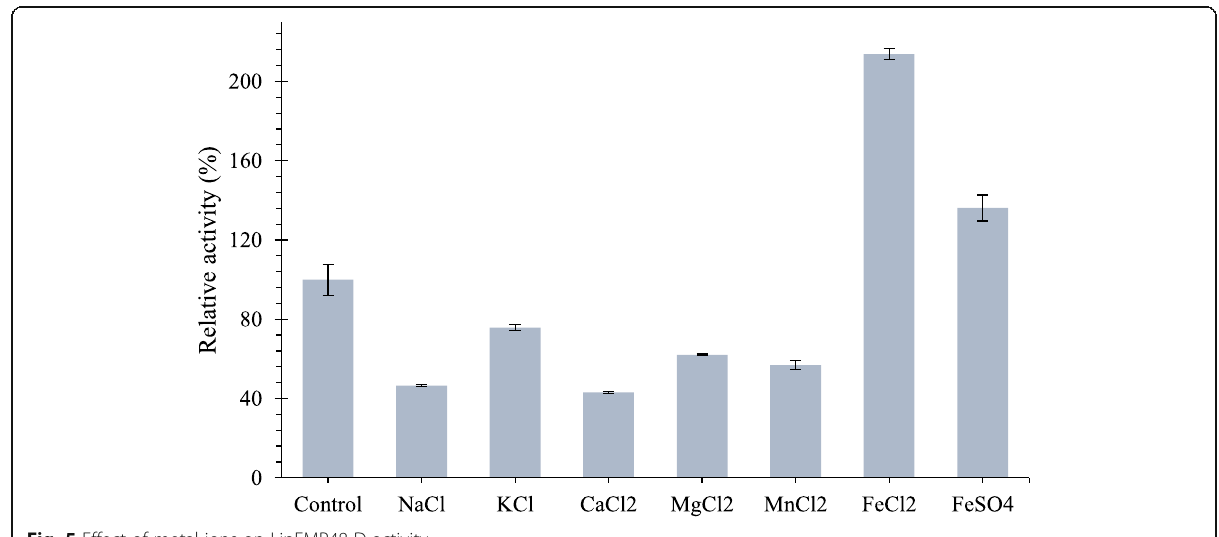
Fig. 5 Effect of metal ions on LipEMP48-D activity